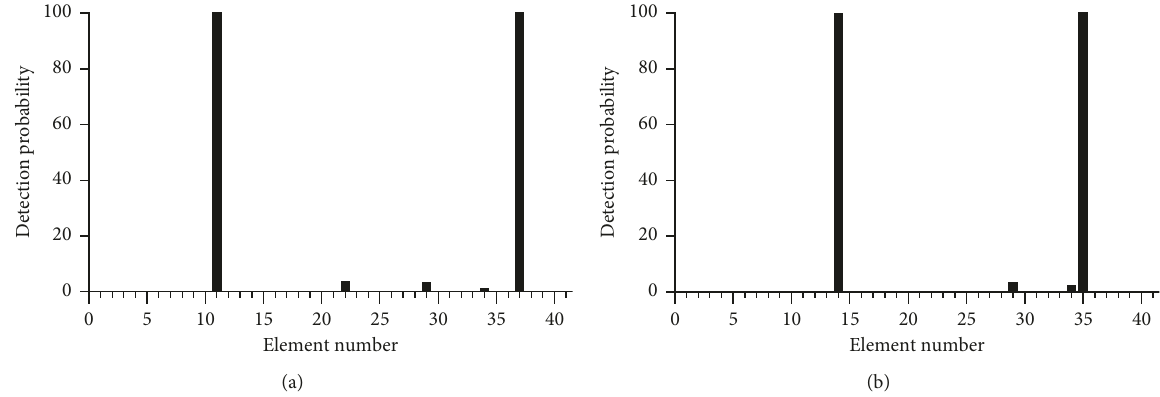
Figure 12: Detection probabilities calculated by the proposed MSECI method with an in-turn damage-checking process (5% noise and 5000 samples). (a) Scenario 1 (damaged element 11 and 37). (b) Scenario 2 (damaged element 14, 18, and